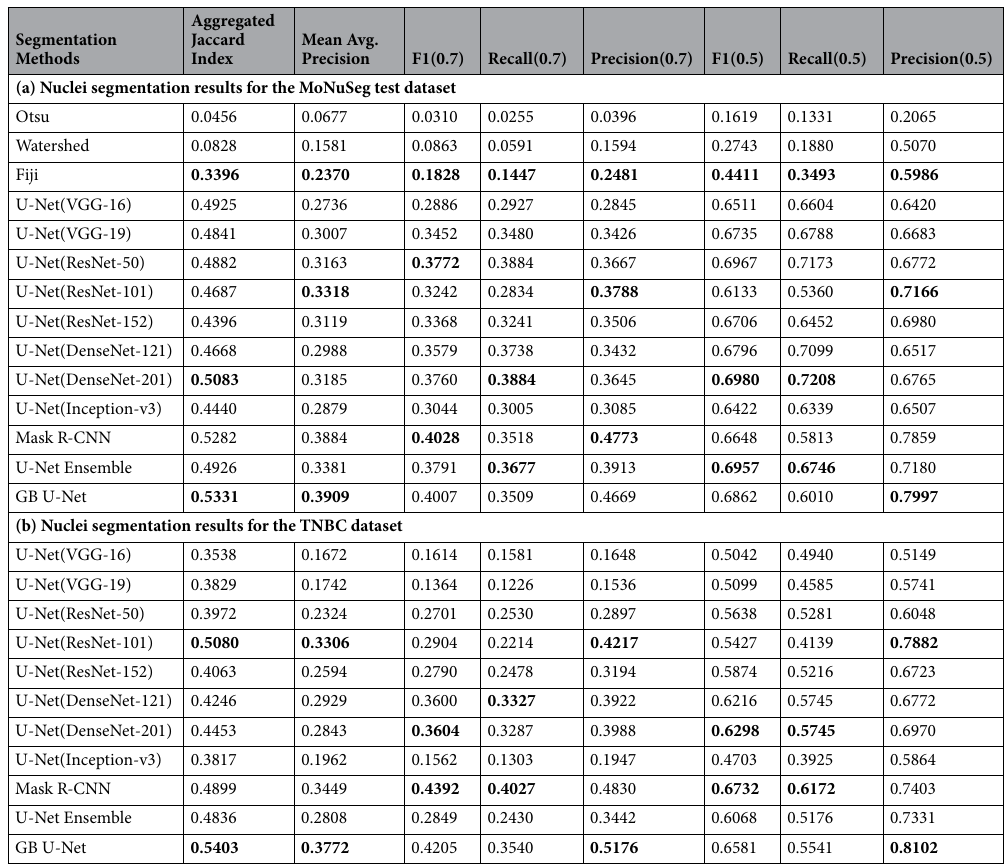
Table 2. F1, recall, and precision metrics are reported for two intersection over union thresholds, 0.5 and 0.7. Bolded values identify the highest scoring segmntation method within 1)classical segmentation, 2)U-Net like DCNNs, 3)Mask R-CNN and ensemble networks, with respect to the evaluation metric.